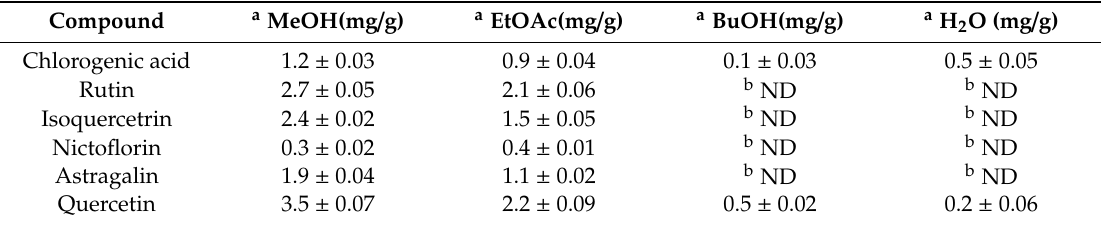
Table 3. Contents of the six phenolic compounds in extract and fractions from S. formosana . Compound